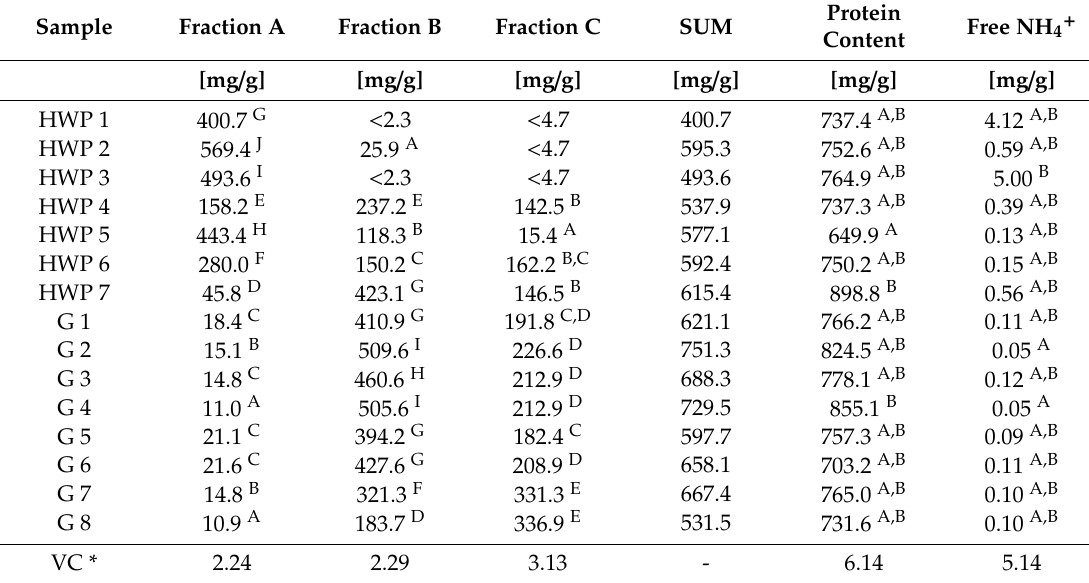
Table 1. Contents of fractions A, B, and C and their sum (SUM), crude protein and free ammonium in the gluten samples (G1–G8) and hydrolyzed wheat proteins (HWP1–HWP7). Values are given as means ( n = 3) and di ff erent capital letters indicate significant di ff erences between the samples in each column (one-way ANOVA, Tukey’s post hoc test, p < 0.05). Sample Fraction A Fraction B Fraction C SUM